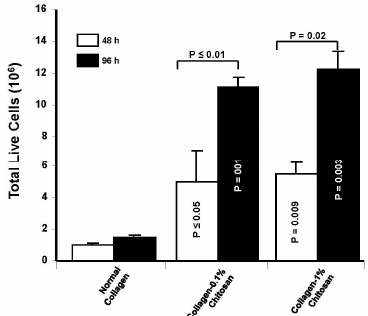
Figure 8. Effect of chitosan ‐ coated collagen membranes on chondrocyte growth and metabolic activity. Following material synthesis, chondrocytes were seeded onto this material and cultured for various time periods. Cell growth was assessed by 3 ‐ (4,5 ‐ dimethylthiazole ‐ 2 ‐ yl) ‐ 2,5 ‐ diphenyltetrazolium bromide (MTT); with results presented as means ± standard deviation (SD) ( n = 5). A difference was considered statistically significant at p < 0.05. Materials 2015 , 8 , page–page